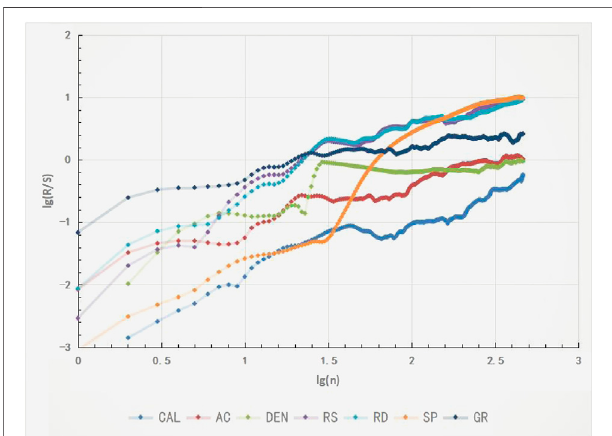
FIGURE 6 | Double logarithm curve of the R/S calculation results of multiple logging curves in well Q1. In this method, the concave section of the curve is identi fi ed as the fracture development section. AC is the acoustic log, DEN is the density log, CAL is the caliper log, SP is the spontaneous potential log, GR is the natural gamma log, RS is the shallow lateral resistivity log and RD is the deep lateral resistivity